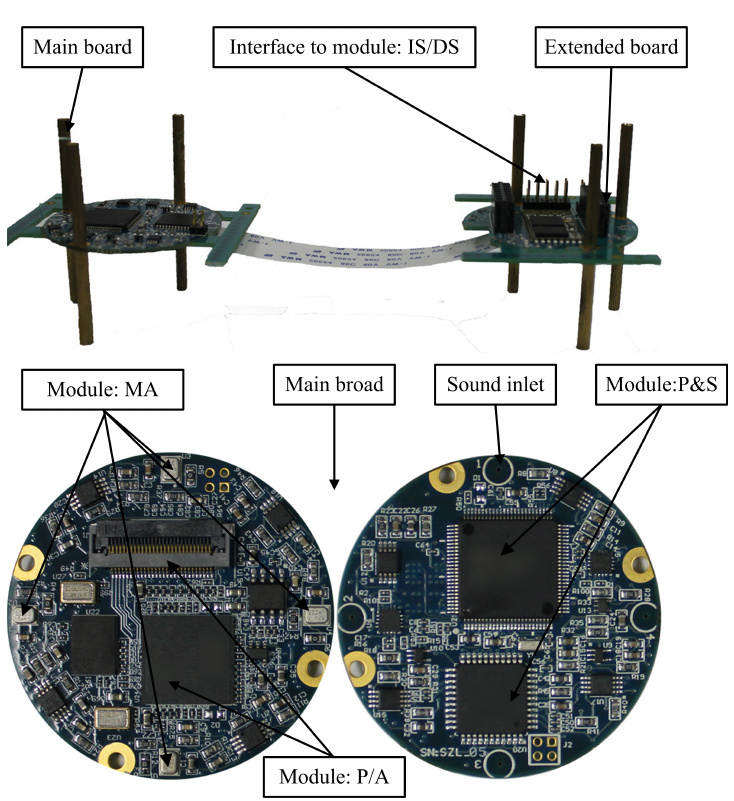
Figure 3. Photograph of the automatic bearing tracking